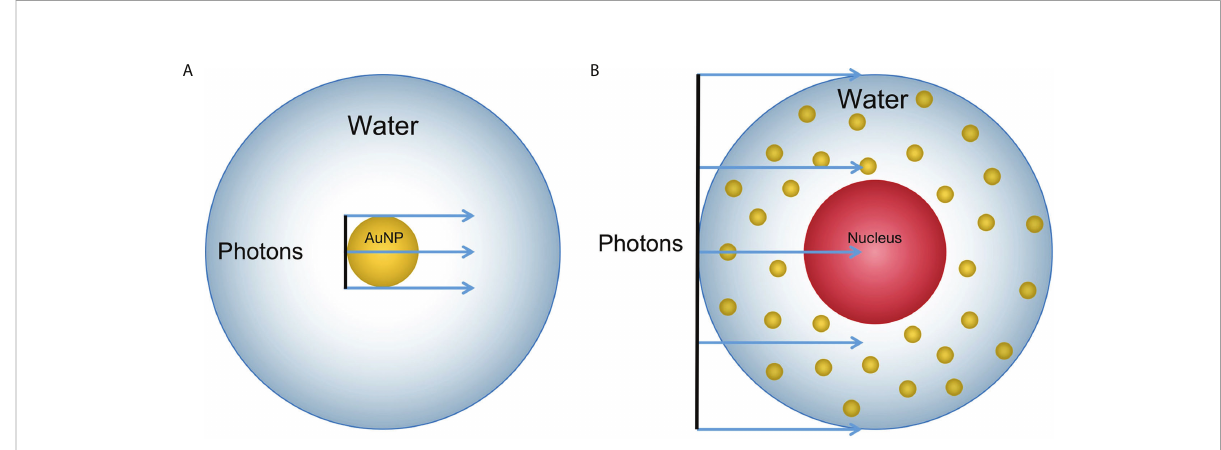
FIGURE 2 Geometry sketch of MC simulation (not the actual scale): (A) A 100 nm diameter AuNP was placed in a 20 m m diameter sphere fi lled with water. A photon beam with the same size as the AuNP in diameter was placed upstream to the AuNP. The dose was scored in the sphere shells with a thickness of 1 nm for 0 to 150 nm; 10 nm for 150 nm to 1.95 m m; and 100 nm for 1.95 m m to 9.95 m m from the AuNP surface. (B) The 10 m m diameter water sphere contained a 5 m m water sphere in the center to model the cell containing a nucleus. The 100 nm diameter NPs were randomly distributed in the cytoplasm. The photon beam had the same diameter as the cell and was placed upstream to the